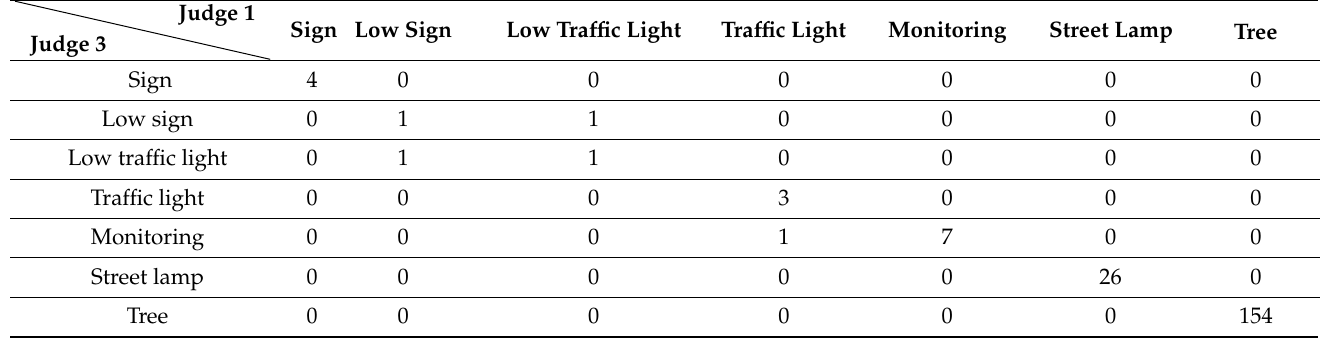
Table A2. This table show the result of Cohen’s kappa coefficient between judge one and judge three.